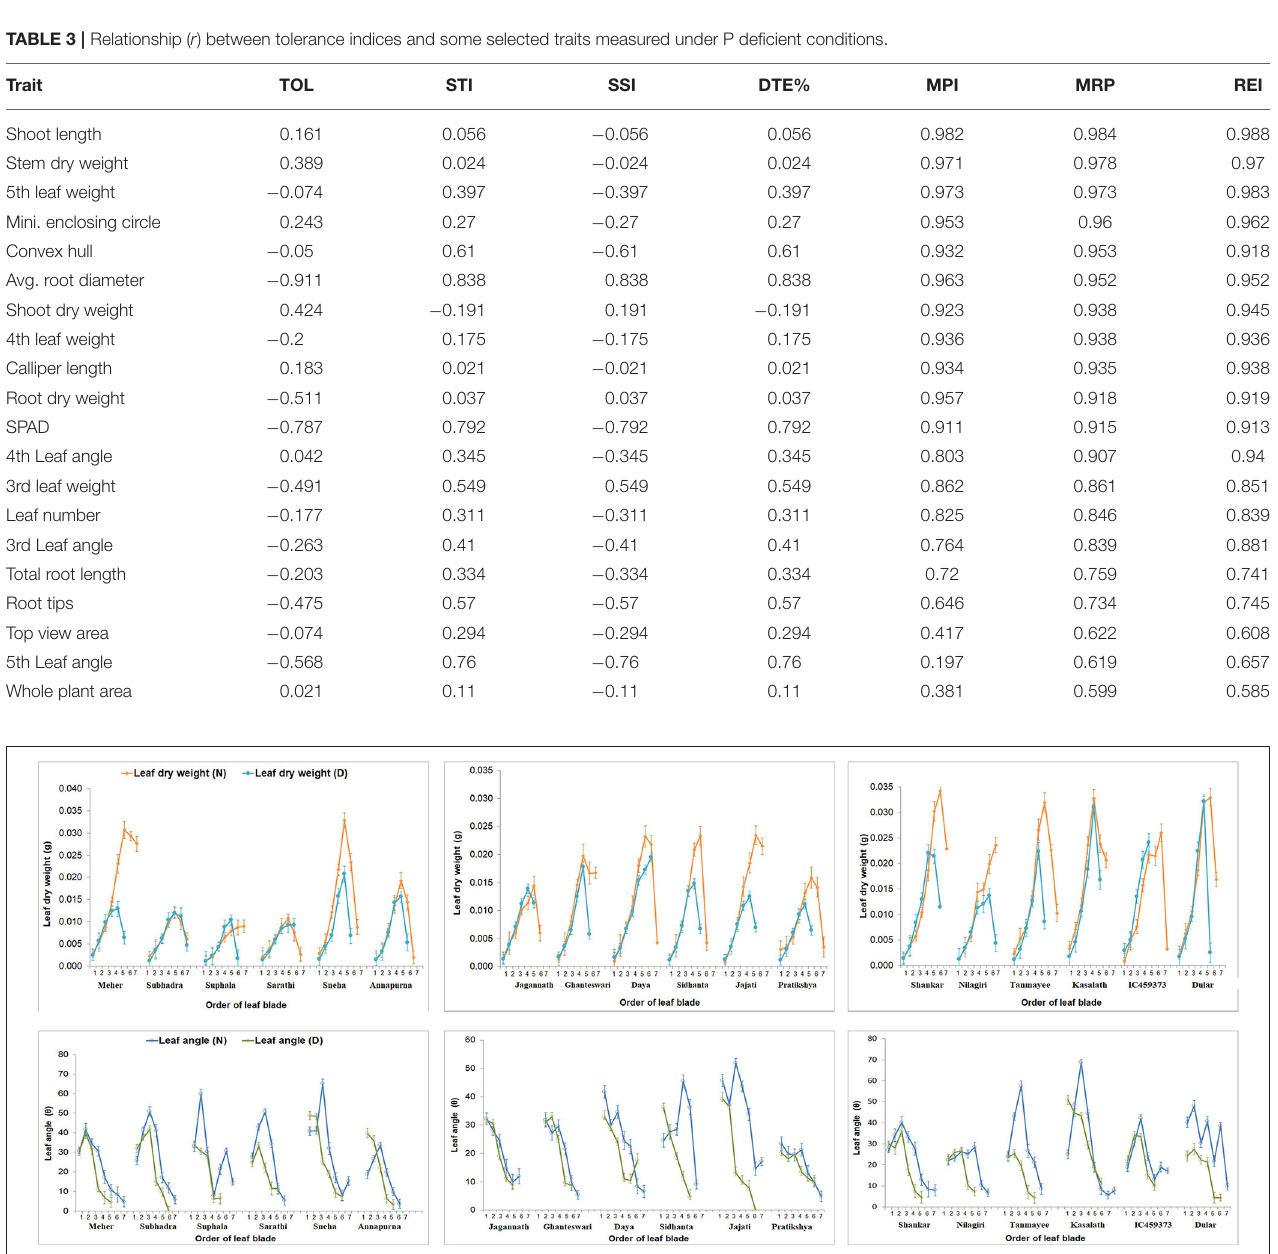
FIGURE 4 | Effect of P on leaf blade weight and leaf angle of the 18 genotypes at all levels and relative comparison between the treatments. Individual points with error bars refer to leaf position from bottom to top. Leaf blade weight and leaf angle were reduced at all levels of leaves. Tolerant genotypes exhibited minimum relative differences for leaf blade and